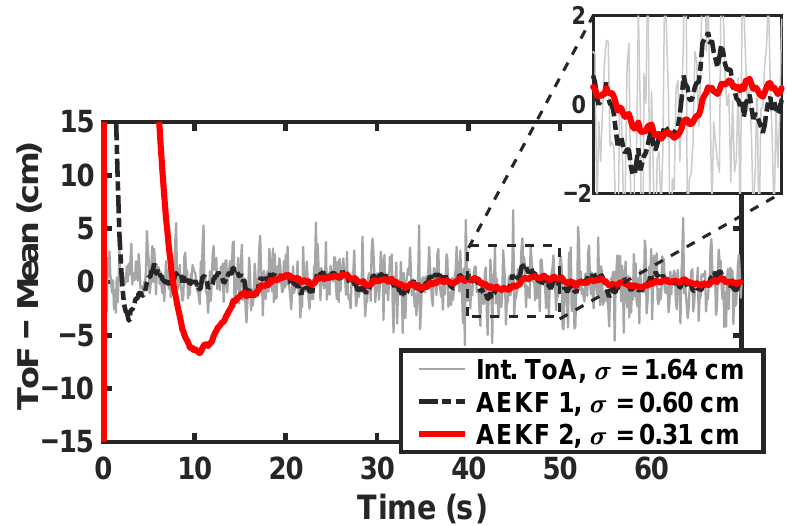
Figure 19. Ranging precision for 1 of the 16 antenna pairs in a cabled configuration using three different ToF estimation techniques. To highlight the estimator variance, we have subtracted the mean for clarity. The interpolated correlator estimator (gray) achieves a ranging precision (standard deviation) below 1.7 cm. The adaptive extended Kalman filter techniques (black, red) drive this precision (standard deviation) as low as 0.3 cm but require more settling time.